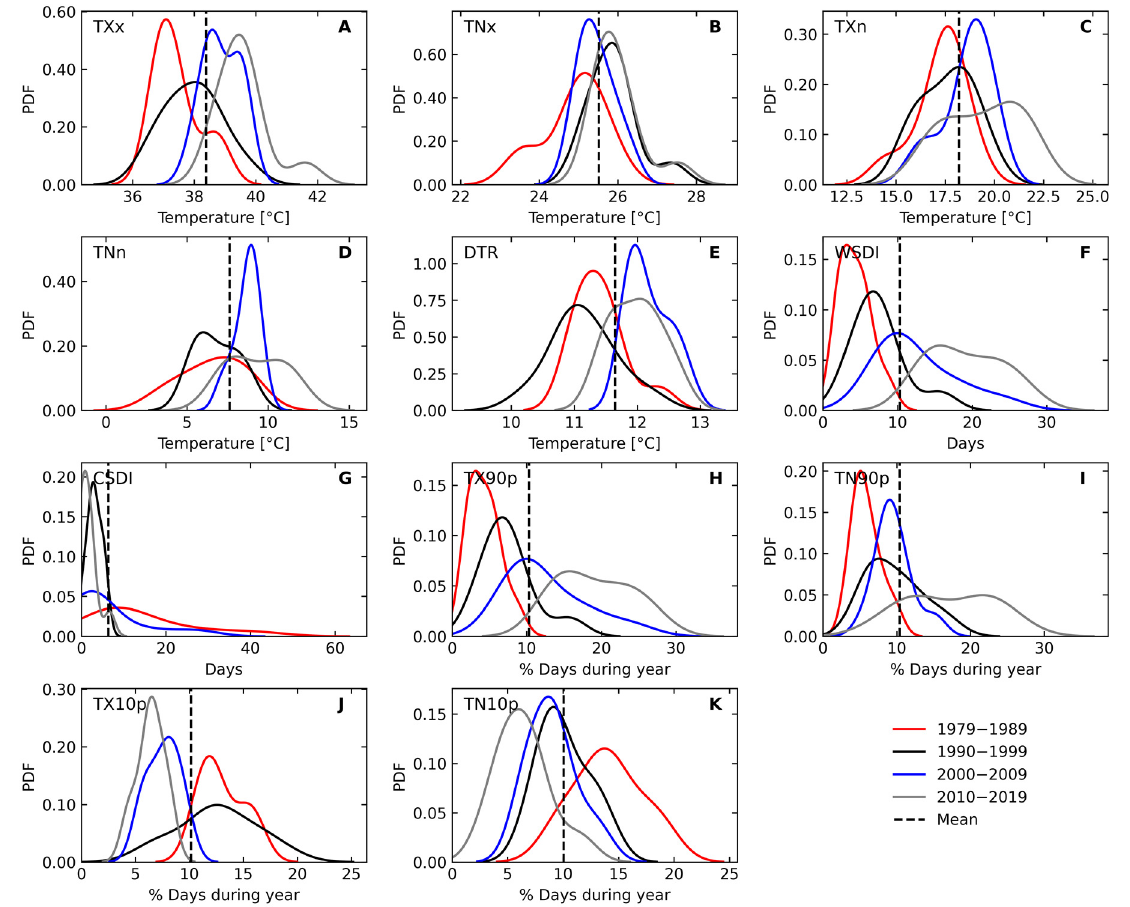
Figure 6. Probability density function (PDF) of the annual frequency of Warmest Day (TXx) ( A ), Warmest Night (TNx) ( B ), Coldest Day (TXn) ( C ), Coldest Night (TNn) ( D ), Diurnal Temperature Range (DTR) ( E ), Warm spell duration (WSDI) ( F ), Cold spell duration (CSDI) ( G ), Warm Days (TX90p) ( H ), Warm Nights (TN90p) ( I ), Cool Days (TX10p) ( J ), and Cool Nights (TN10p) ( K ) in the Brazilian Midwest from 1979 to 2019.